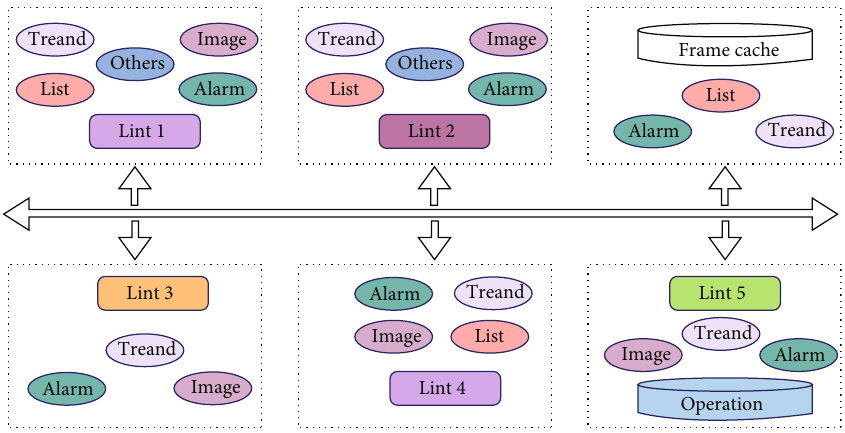
Figure 4: Structural design diagram of the enhanced algorithm